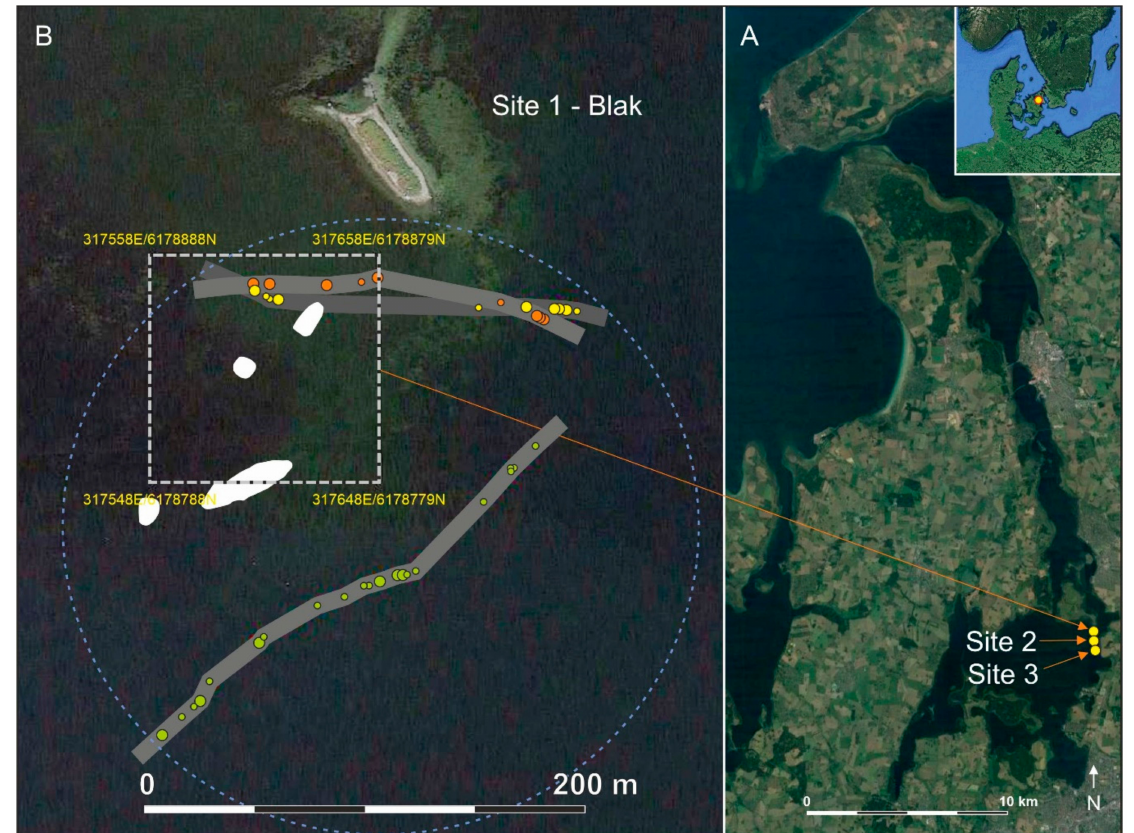
Figure 13. ( A ): The three already recorded Late Mesolithic sites in Roskilde Fjord, site 1 (401257-3), site 2 (401257-56), and site 3 (401257-57), selected for testing of acoustic response. ( B ): Especially site 1, the ‘Blak’ site, is interesting because it is well-documented by intensive investigations, including an excavation based on a 100 × 100 m recording area (white broken square). Preserved cultural deposits (white patches) and numerous cultural indicators were recorded inside and around the recording area. Each of the three sailing lines, and their recorded noise columns, are shown with an individual grey shade and a specific dot colour. The size of the dots is equivalent to their estimated significance. The estimated outline of the site is marked with as a broken blue circle. Zone 33 UTM coordinates. Graphics: